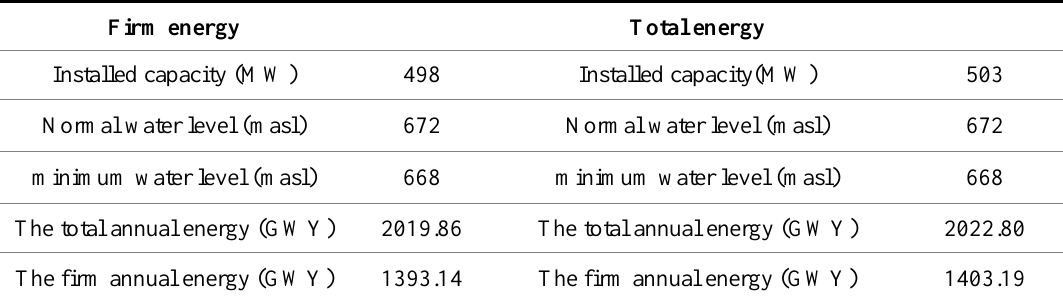
Table 3. The results of the IWO-WEAP